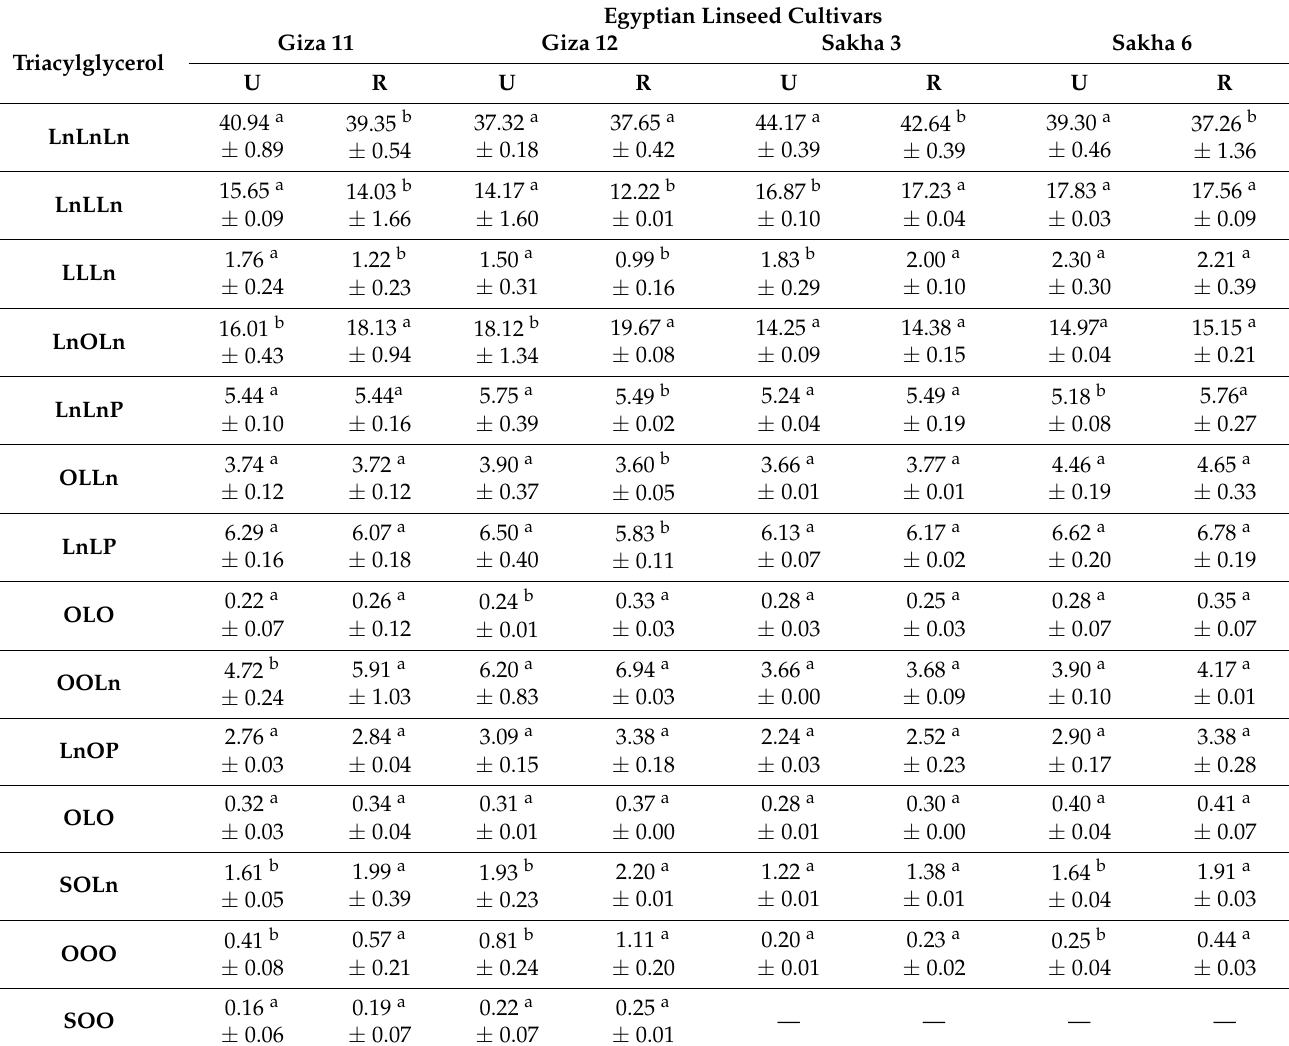
Table 5. Abundance of triacylglycerols (%) in oil extracted from four Egyptian unroasted and roasted linseed